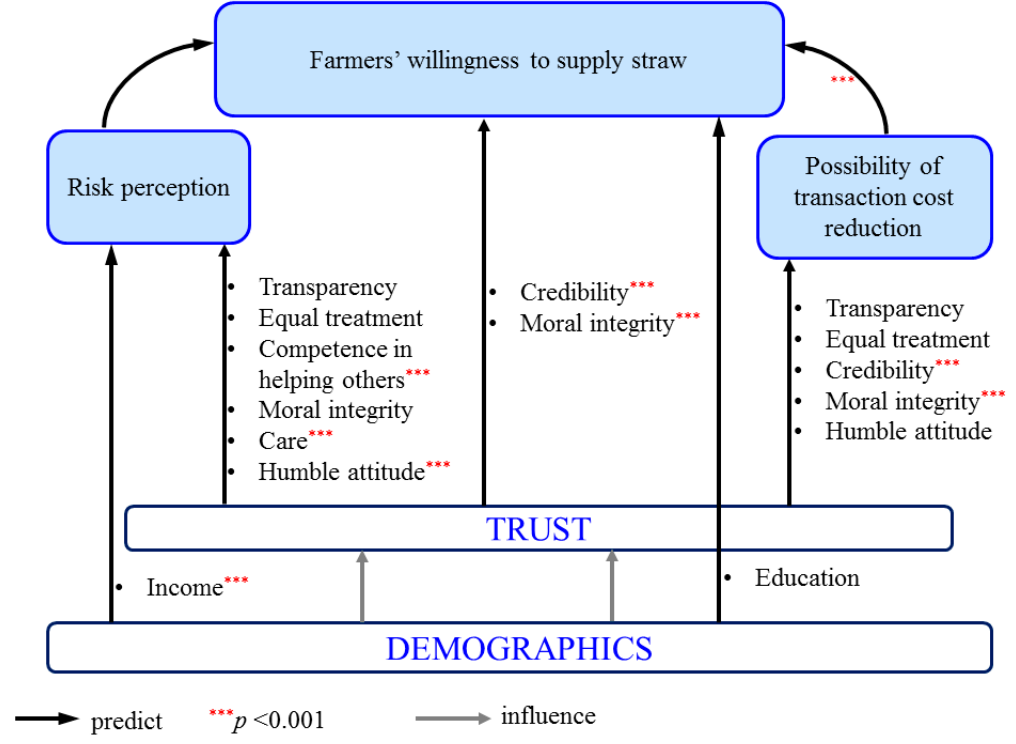
Figure 6. Model of the influence trust.